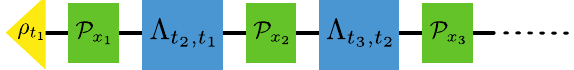
FIG. 3. Markovian process. For a Markovian process, the system dynamics in between intermediate times (depicted as the blue boxes) can be modeled by maps Λ depend on previous outcomes (i.e., there is no memory). The measurement statistics are obtained by measuring in the classical basis at times t 1 ; t 2 ; t 3 ; … (depicted in green); before the first measurement, the system is in the state ρ